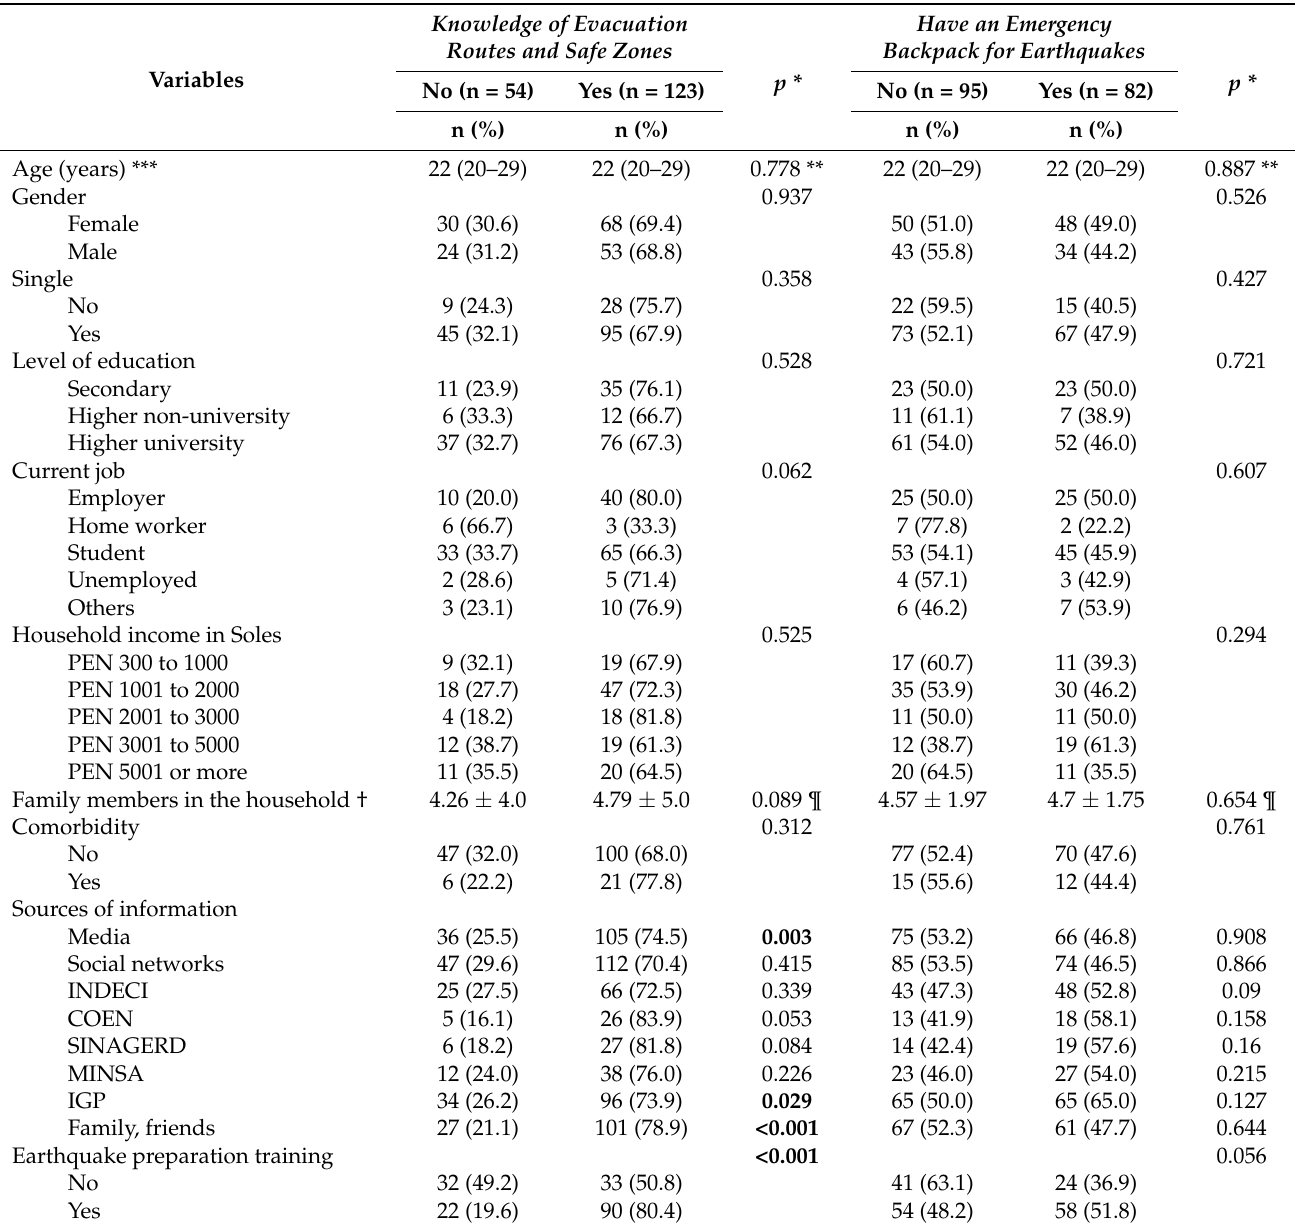
Table 2. Factors associated with knowledge about evacuation routes and having an emergency backpack in case of